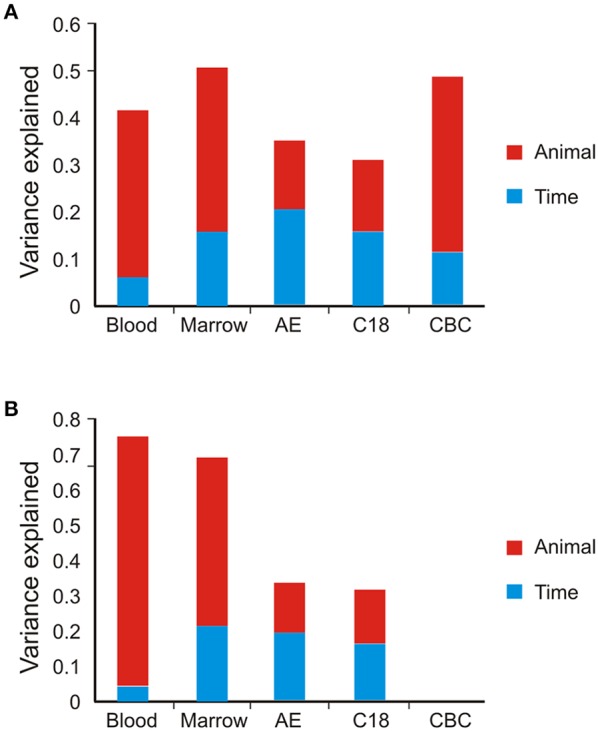
Principal component variance component analyses. Bar graphs show the weighted average contribution of among animal (red) and among timepoint (blue) variance to gene expression, metabolite, and complete blood counts. (A) Full data set. (B) Reduced dataset after removal of low abundance transcripts or metabolites.